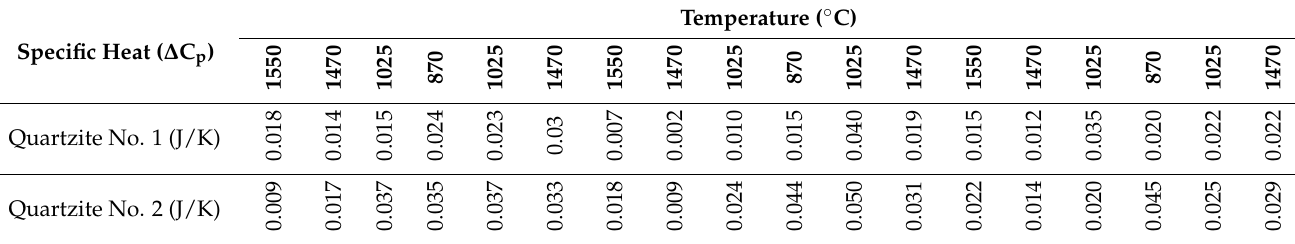
Table 4. Heat capacity ( ∆ C p ) values of quartzite at the operating temperatures of melting